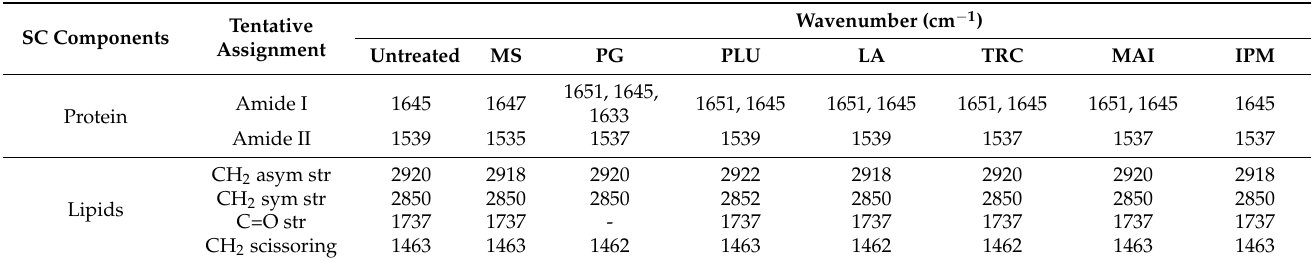
Table 2 . FTIR spectral assignments of porcine SC sheets treated with MS and solvents .